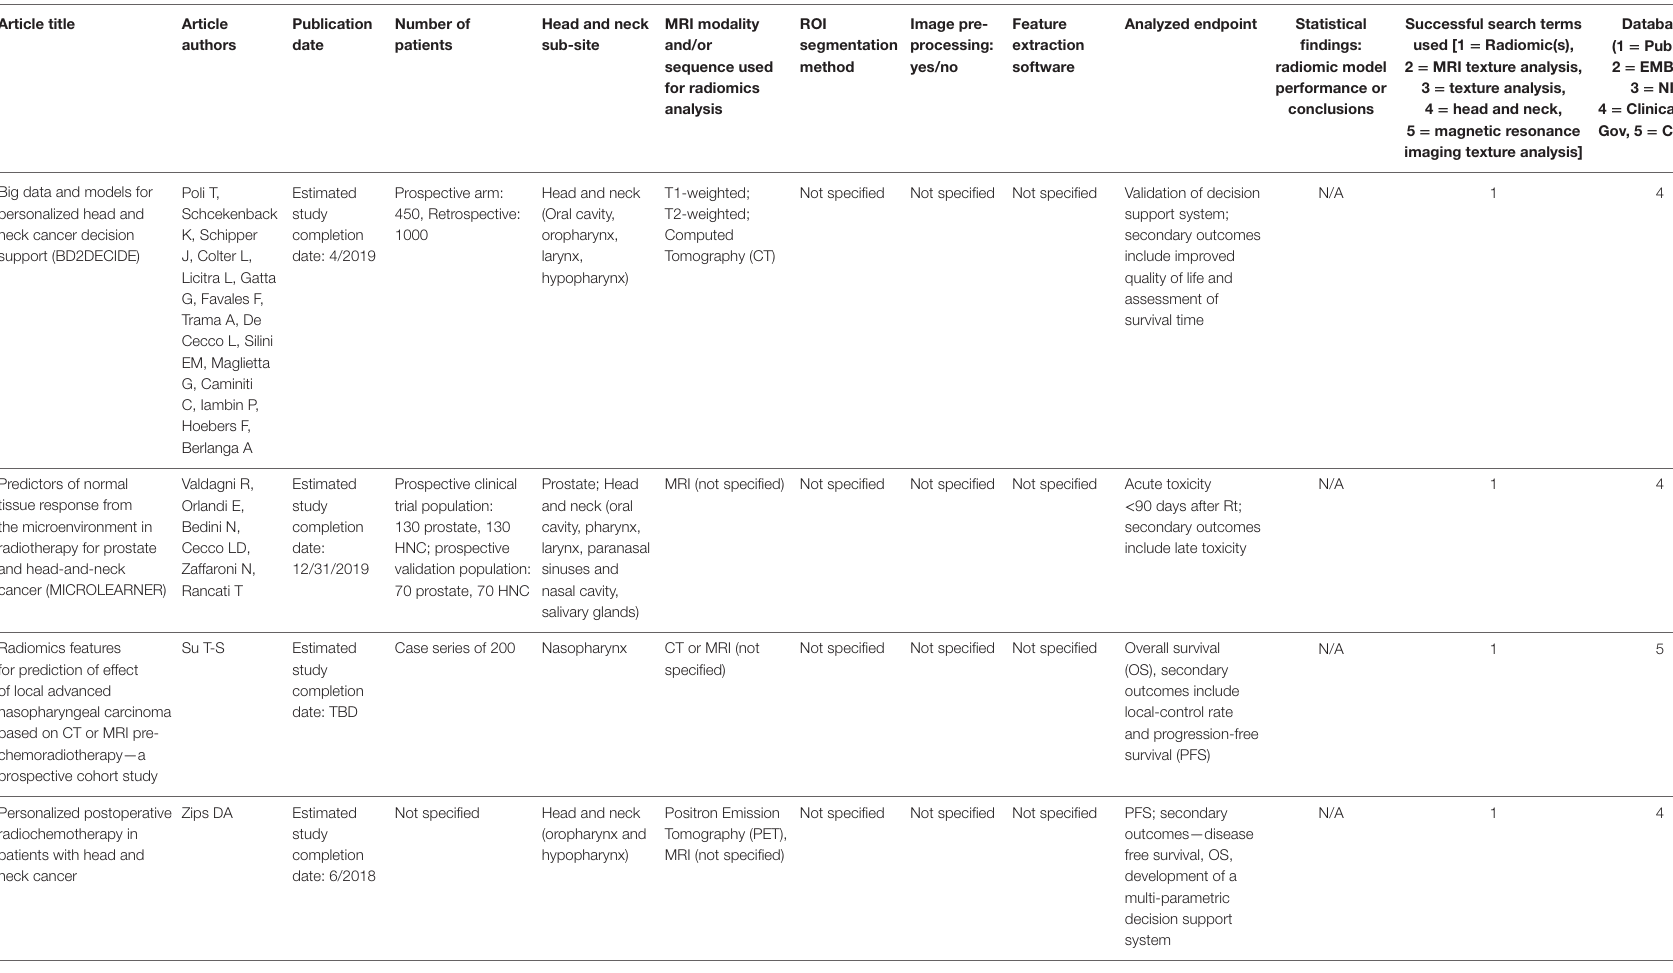
taBLe 2 | Magnetic resonance imaging (MRI) radiomics in HNC: ongoing